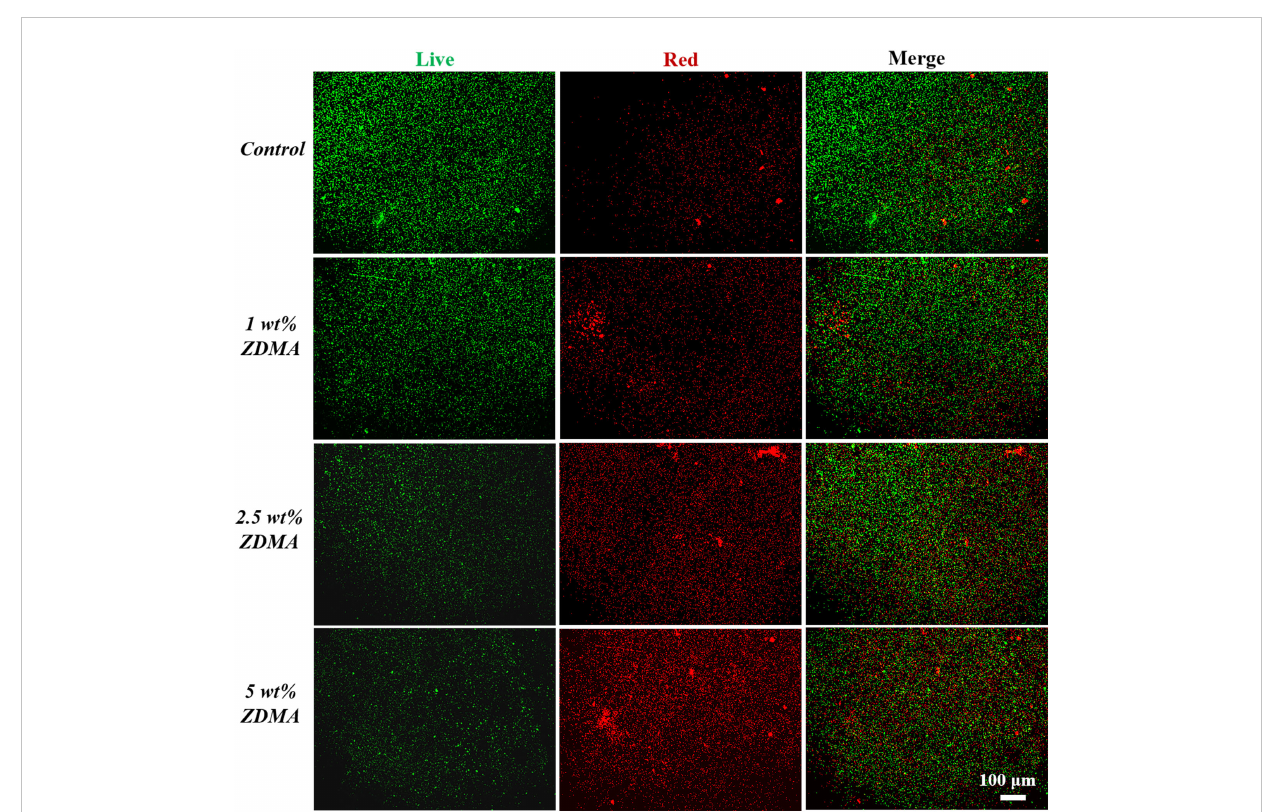
FIGURE 8 Representative live/dead staining images of C. albicans bio fi lms on specimens of each